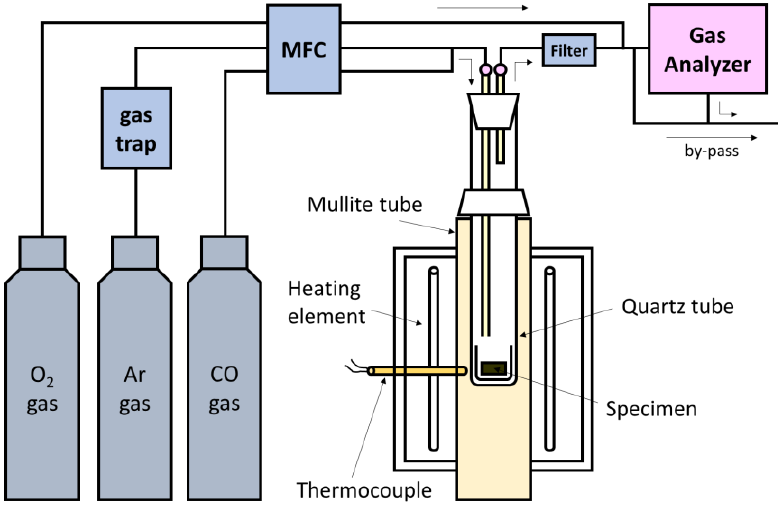
Figure 1. Schematic presentation of the experimental apparatus.